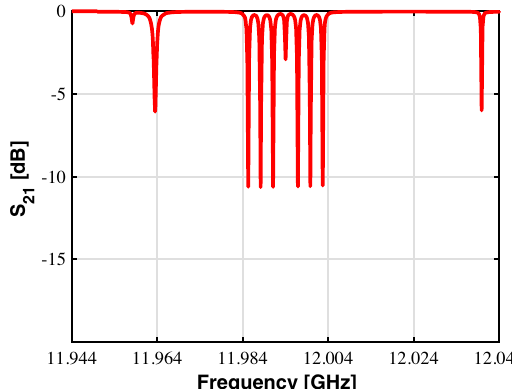
FIG. 14. Transmission spectrum of the pulse compression system based on the bowl-shape open cavities.